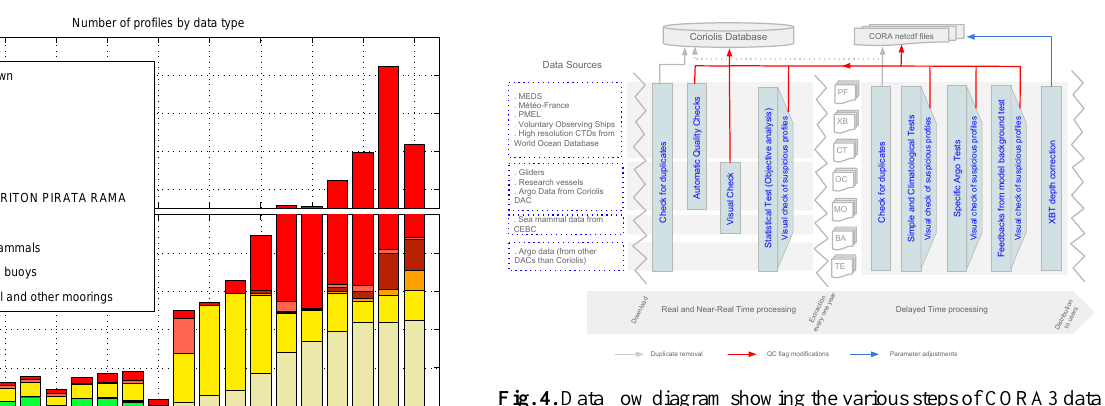
Fig. 4. Data flow diagram showing the various steps of CORA3 data